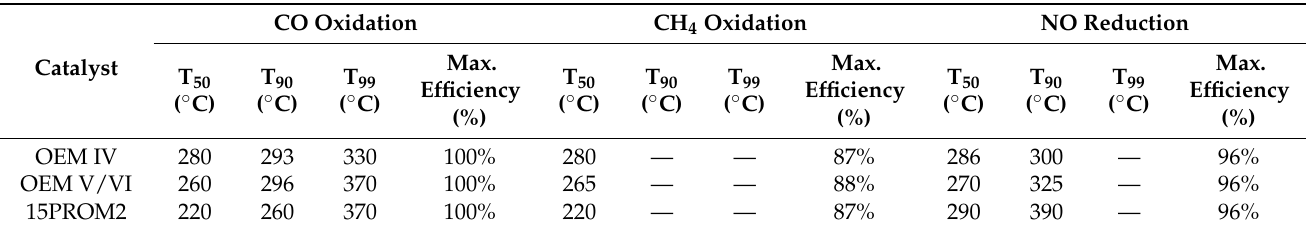
Table 6. Comparison of tested catalysts OEM IV, OEM V/VI and 15PROM2 under lean-burn conditions ( λ = 1.03).